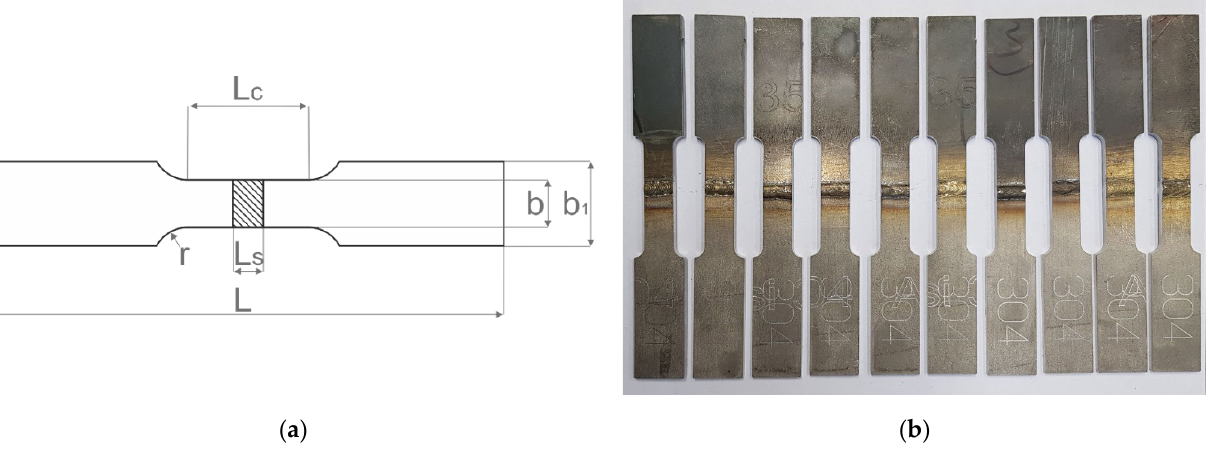
Figure 5. Tensile samples: ( a ) tensile sample geometry: L—total length; L c —gauge length; L s —thickness of sample; b and b 1 —width; ( b ) laser-cut samples prepared for testing.